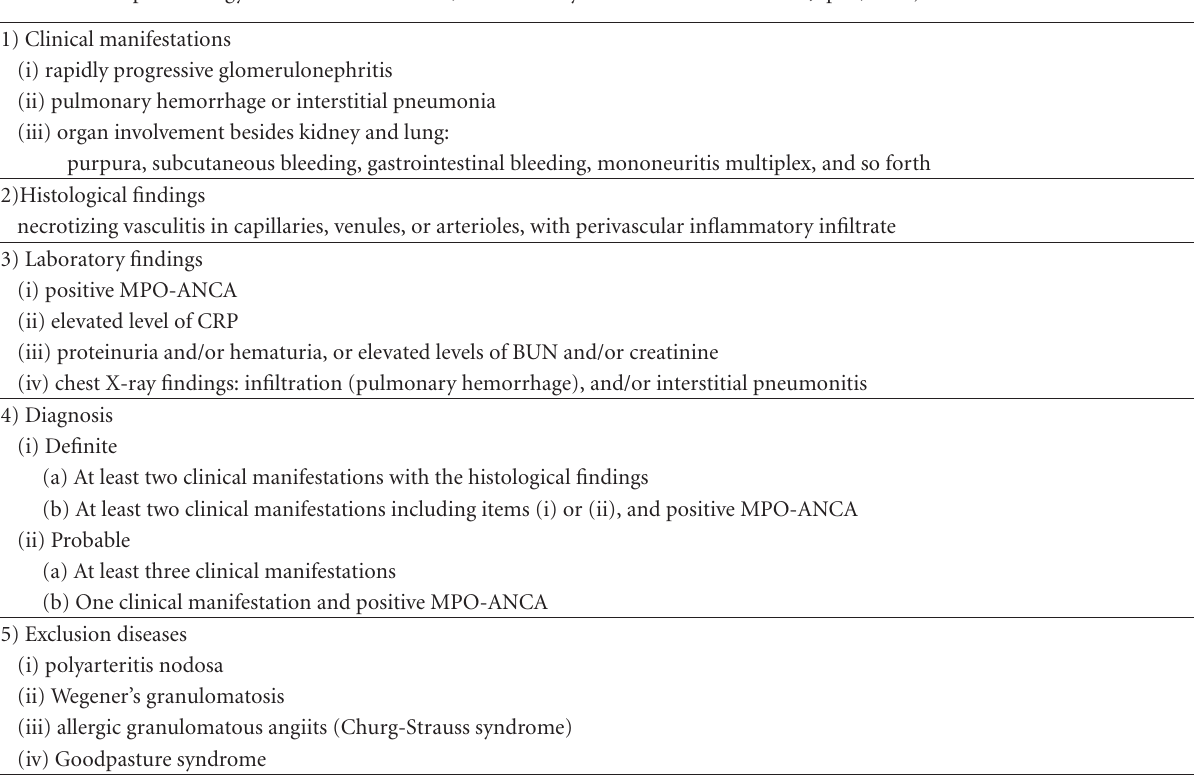
Table 2: Proposed diagnostic criteria for microscopic polyangiitis (MPA). (Research Committee on Intractable Vasculitis and Research Committee on Epidemiology of Intractable Diseases, The Ministry of Health and Welfare of Japan,